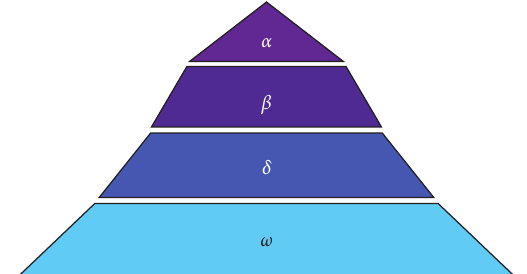
Figure 3: Hierarchy of the grey wolf (dominance decreases from top to